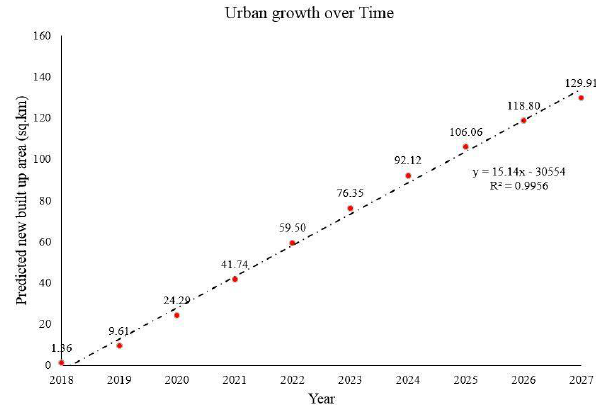
Figure 9. Predicted urban growth (in km 2 ) from 2018 to 2027 for Bangkok.